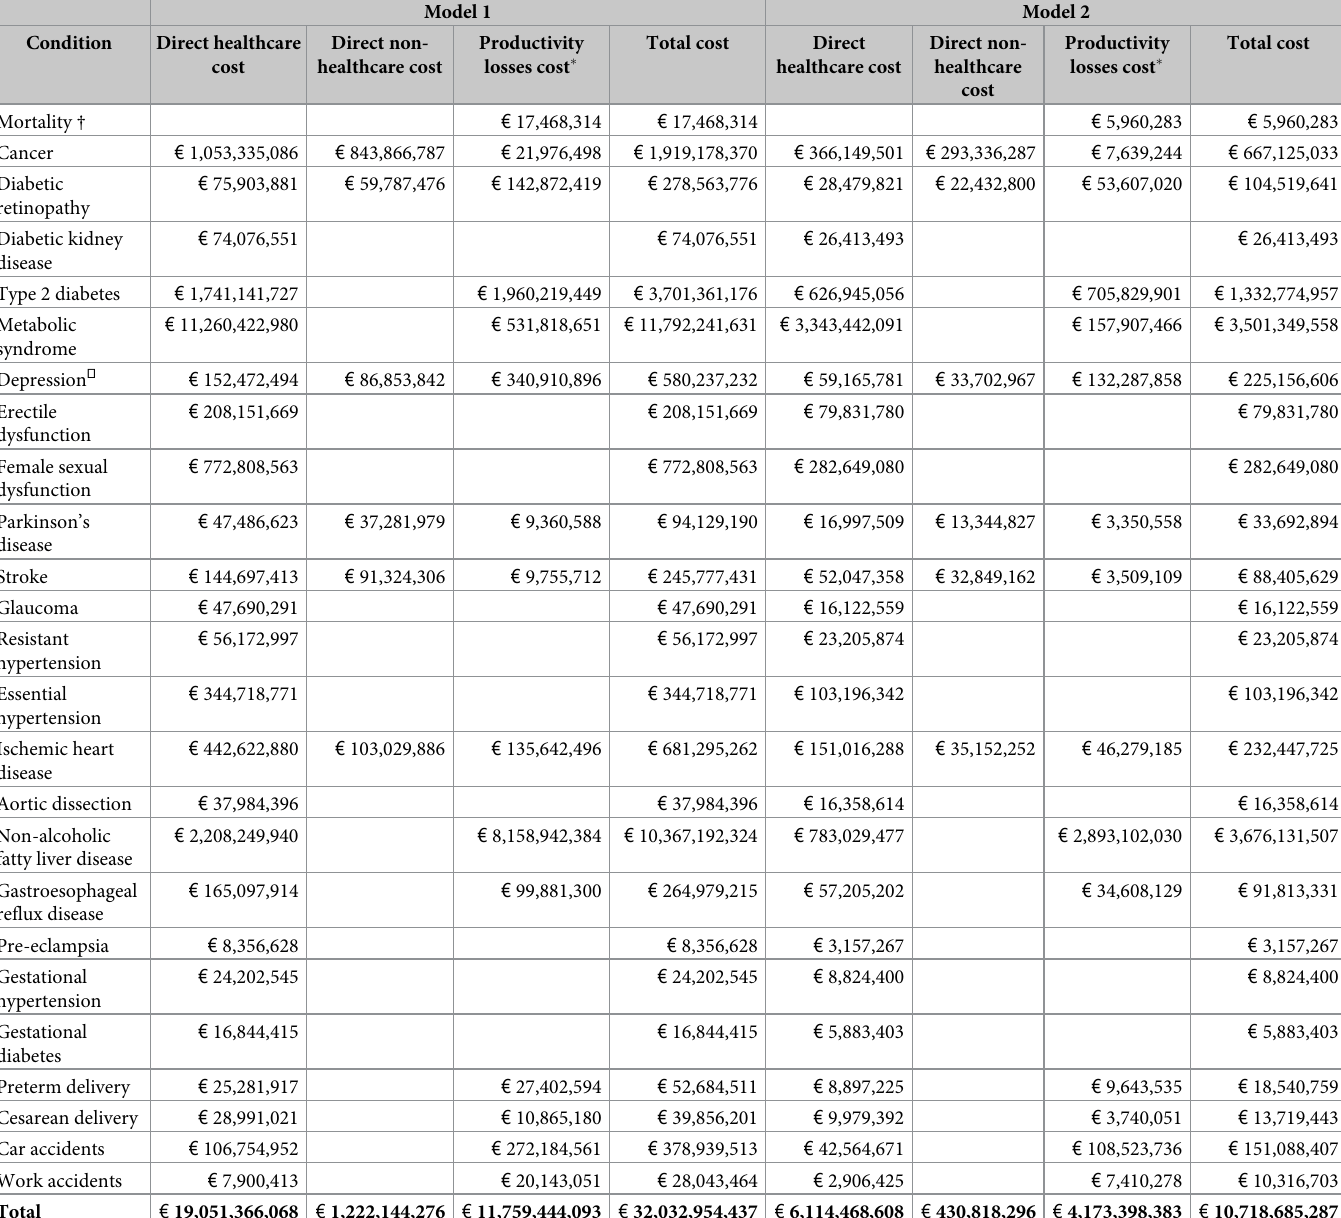
Table 4. Annual economic burden of conditions influenced by OSA in